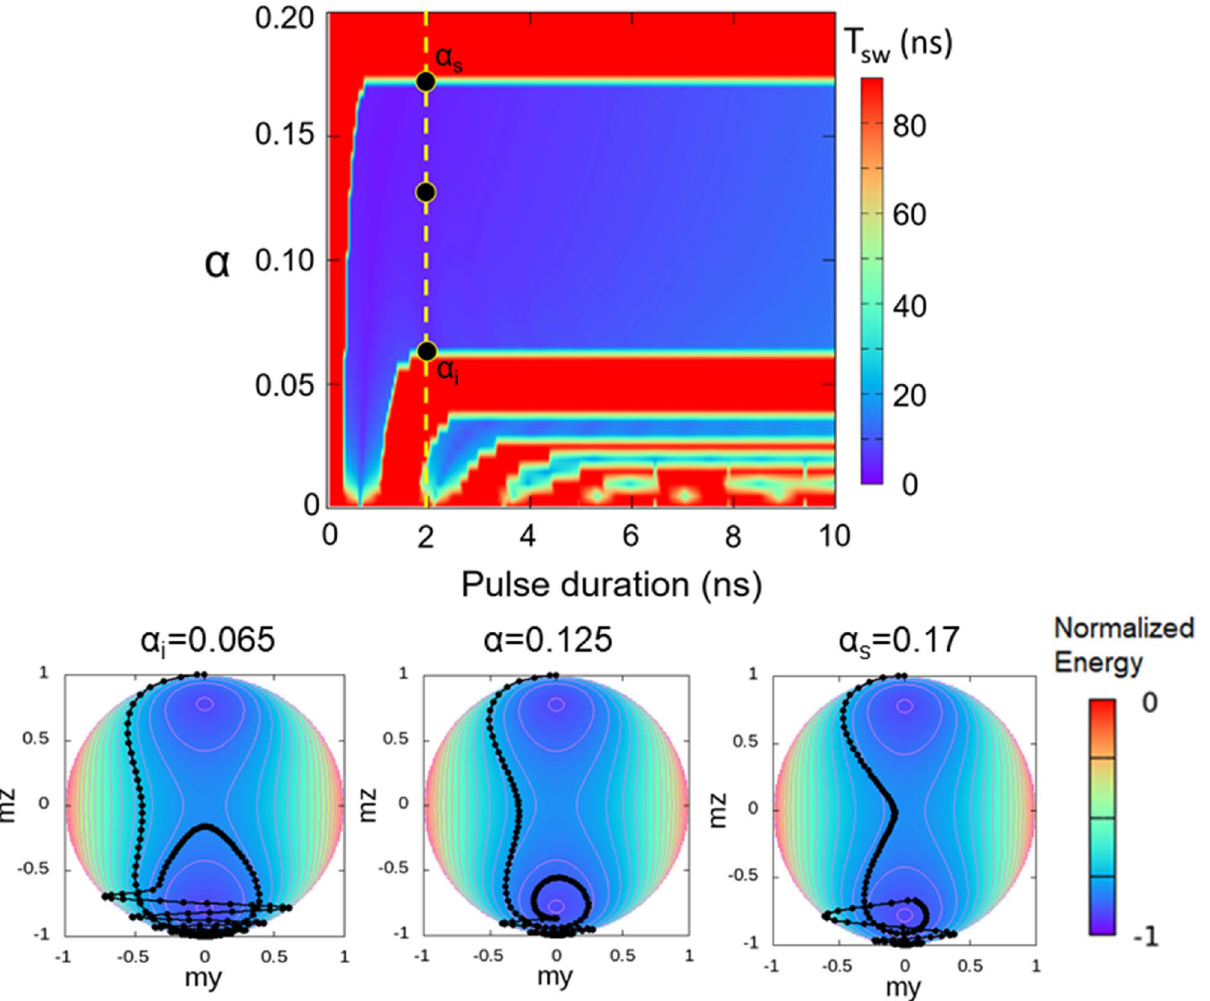
Figure 7. (Top panel) Effect of the damping parameter α on the magnetization switching time. The simulation is performed with p = 0.35 and H ip = 0.0324 T; the switching probability is related with the switching time. (Bottom panel) Magnetization trajectories and normalized energies represented for the damping values α i , α and α s represented in the top